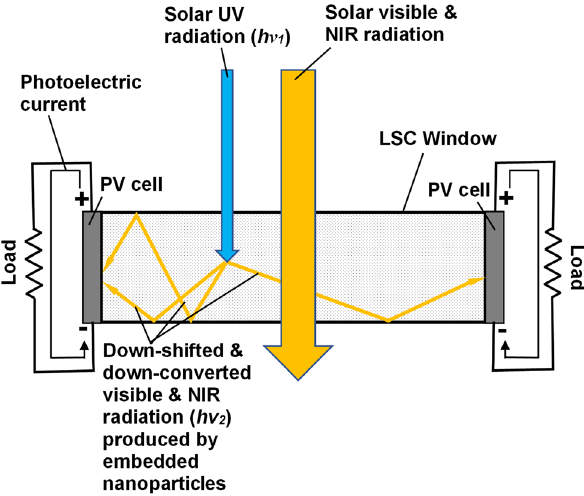
Figure 1: Schematic of a photovoltaic window in the con fi guration of a luminescent solar concentrator ( LSC ) with PV cells attached to the edges.